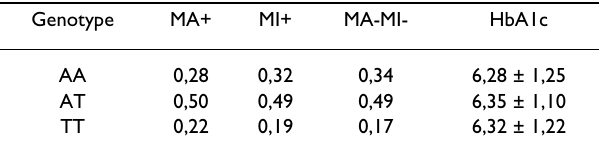
Table 4: Genotype frequencies in CAT gene according to presence of vascular complications and values of glycated haemoglobin according to the